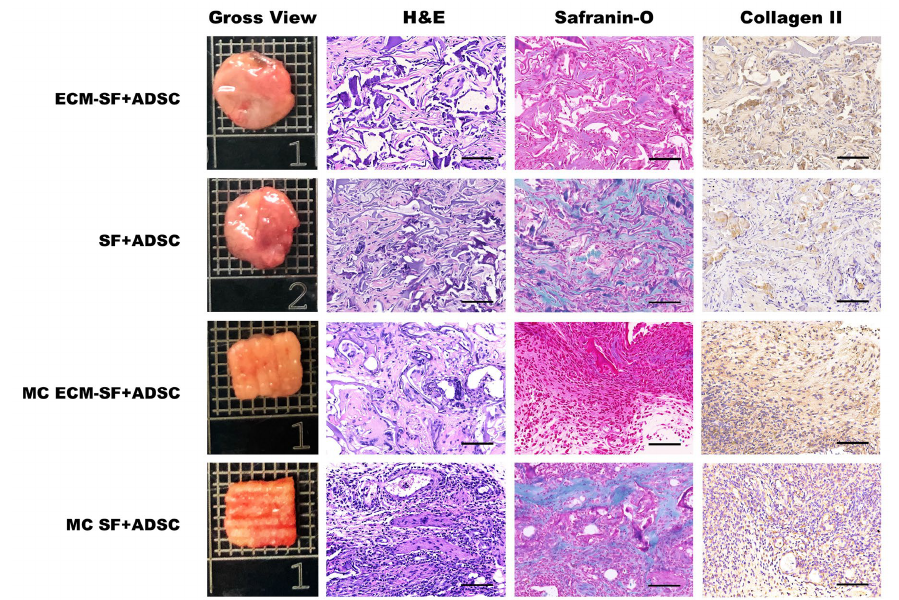
Figure 5. Gross view and histological examinations of engineered cartilage at 4 weeks in vivo. Bar = 20 µ m.